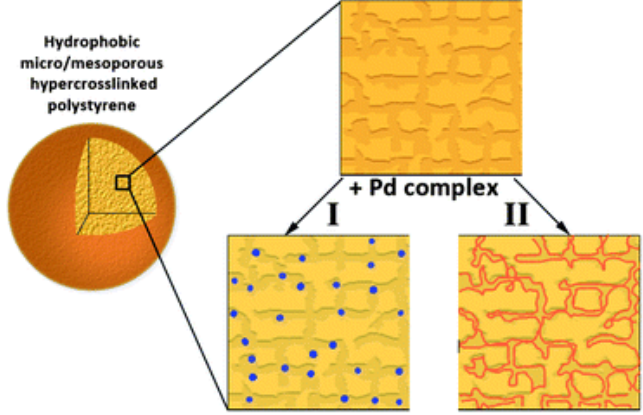
Figure 7. Schematic representation of Pd complexes embedded in HCL polystyrene depending on the complex/resin compatibility: I for low complex/resin compatibility; and, II for high compatibility. Reproduced from ref. [93] with permission of the Royal Society of Chemistry (London, UK).